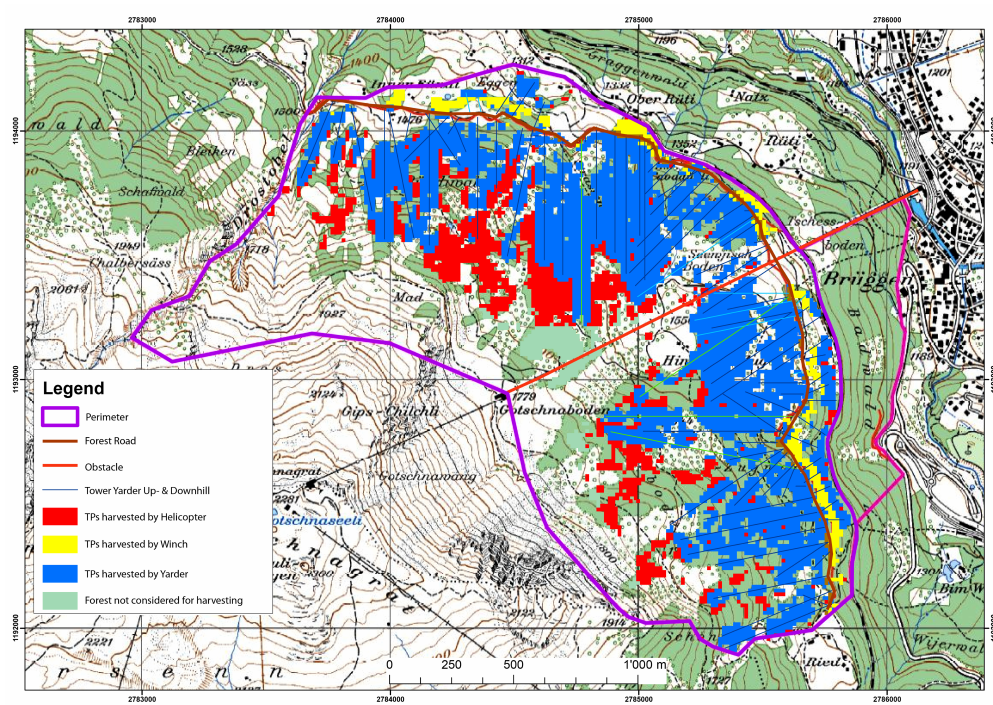
Figure 7. Application of an operational harvesting and cable road layout model (Breschan et al. [39]) in the Gotschna area in the canton of Grisons, Switzerland (topographic map © swisstopo